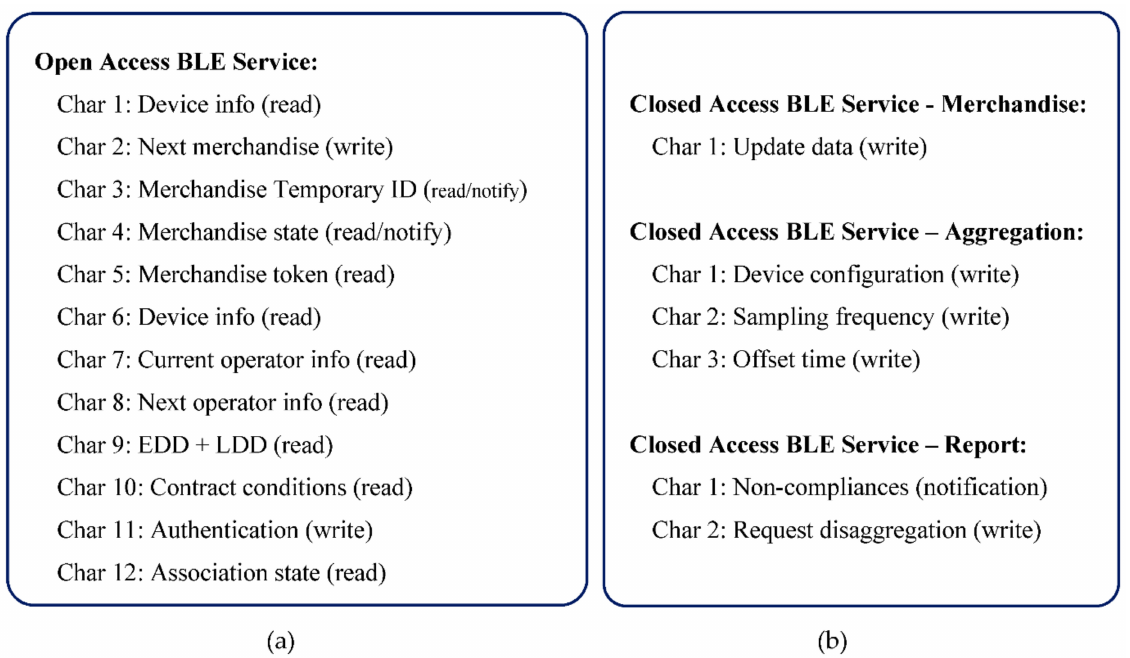
Figure 6. BLE Services API. ( a ) Open Access BLE Service. ( b ) Closed Access BLE